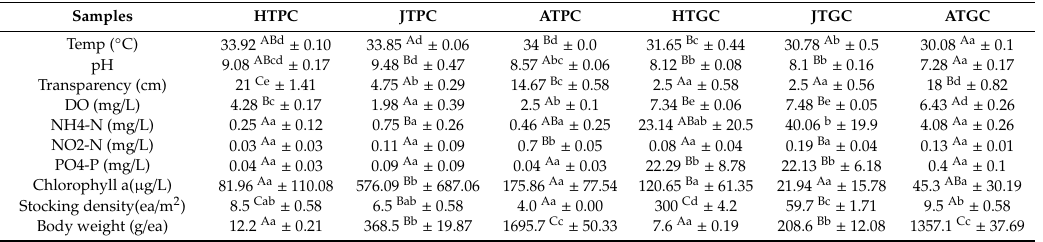
Water quality indices in di ff erent periods of pond and greenhouse cultivation of Chinemys reevesii